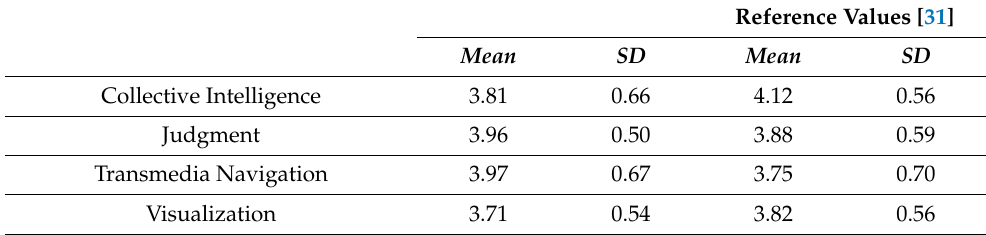
Table 5. Transmedia profile. Source: Authors’ creation.